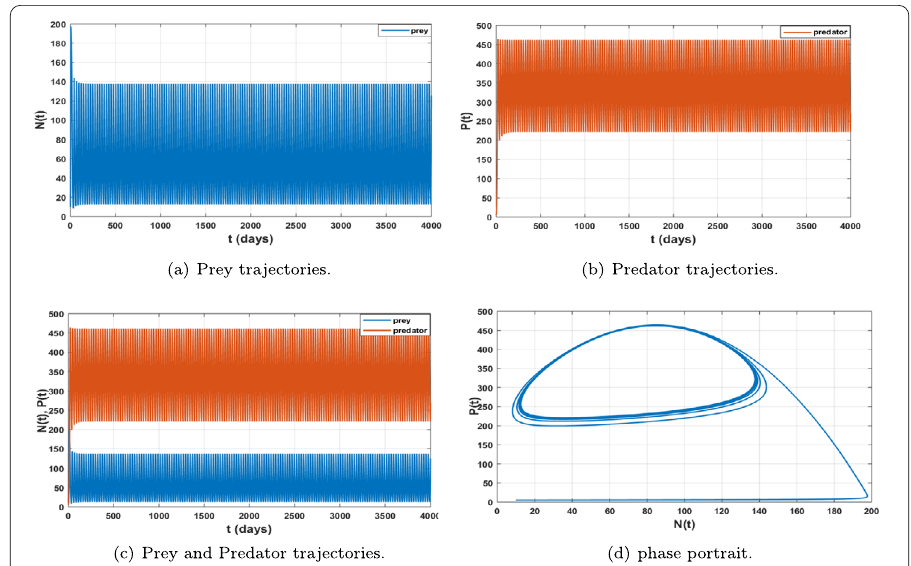
Figure 9 Limit cycle behavior of the solution of system ( 2.3) at the coexisting equilibrium E + 3 corresponding to δ 1 =